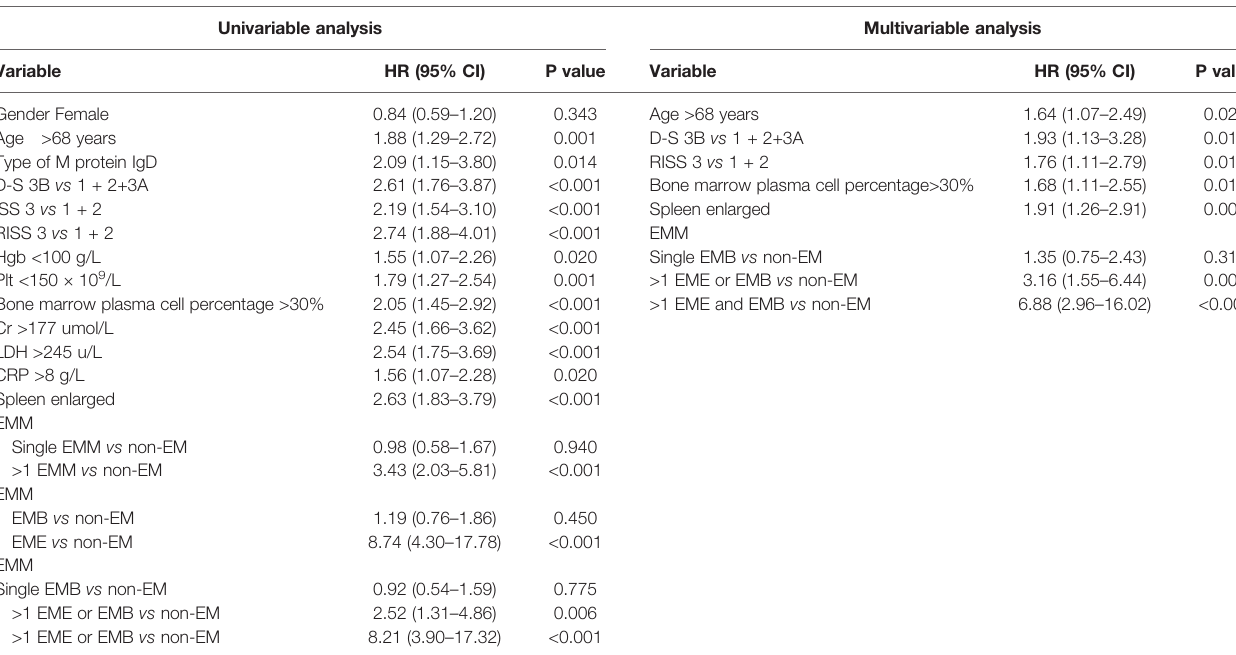
TABLE 4 | OS of MM